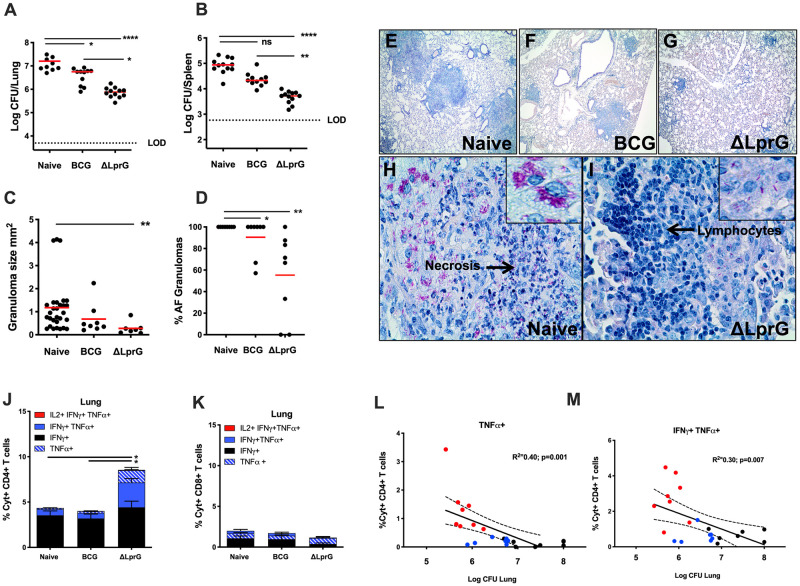
Protective efficacy of ΔLprG and BCG vaccines against Mtb challenge in C3HeB/FeJ mice.Colony-forming units (CFU) from A) lung or B) spleen at week 4 following challenge with 75 CFU of aerosolized Mtb H37Rv. Histopathology on lungs from naïve and vaccinated C3HeB/FeJ mice following aerosol Mtb challenge showing C) individual granuloma size (mm2) in lungs from mice at week 4 following challenge and D) percent of granulomas that contain visible acid-fast organisms. Dots represent individual animals (C) and individual granuloma measurements (D). Kruskall-Wallis with Dunn’s correction for multiple comparisons; * p<0.05; ** p<0.01; *** p<0.001; **** p<0.0001. Red bar = median. Representative images of Ziehl-Neelsen acid-fast staining in affected lung from E) Naïve F) BCG vaccinated and G) ΔLprG vaccinated mice, 4 weeks post-Mtb aerosol challenge, at 100x magnification. Representative images of Ziehl-Neelsen acid-fast staining in affected lung from H) Naïve and I) ΔLprG vaccinated mice, 4 weeks post-Mtb challenge, at 400x magnification. Percent cytokine positive (%Cyt+) antigen-specific T lymphocyte responses as measured by intracellular cytokine staining (ICS) following stimulation with PPD (Synbiotic; Tuberculin OT) in J) CD4+ or K) CD8+ CD44+ T lymphocytes isolated from lungs of C3HeB/FeJ mice at week 4 following aerosol Mtb challenge; * p<0.05, Kruskall-Wallis with Dunn’s corrections for multiple comparisons. Pearson’s correlation (R2) of L) TNFα+ and M) IFNγ+ TNFα+ CD44+ CD4+ T cells in lung post- Mtb challenge with Log10 CFU in lung following challenge. Protection data (A-D) is representative of 3 individual challenge experiments with 8–10 mice per group. Lung leukocyte levels post-challenge and CFU correlation analyses (J-M) are representative of 2 independent Mtb challenges with 8–10 mice per group. Red = ΔLprG-vaccinated; Blue = BCG-vaccinated; Black = Naïve mice.